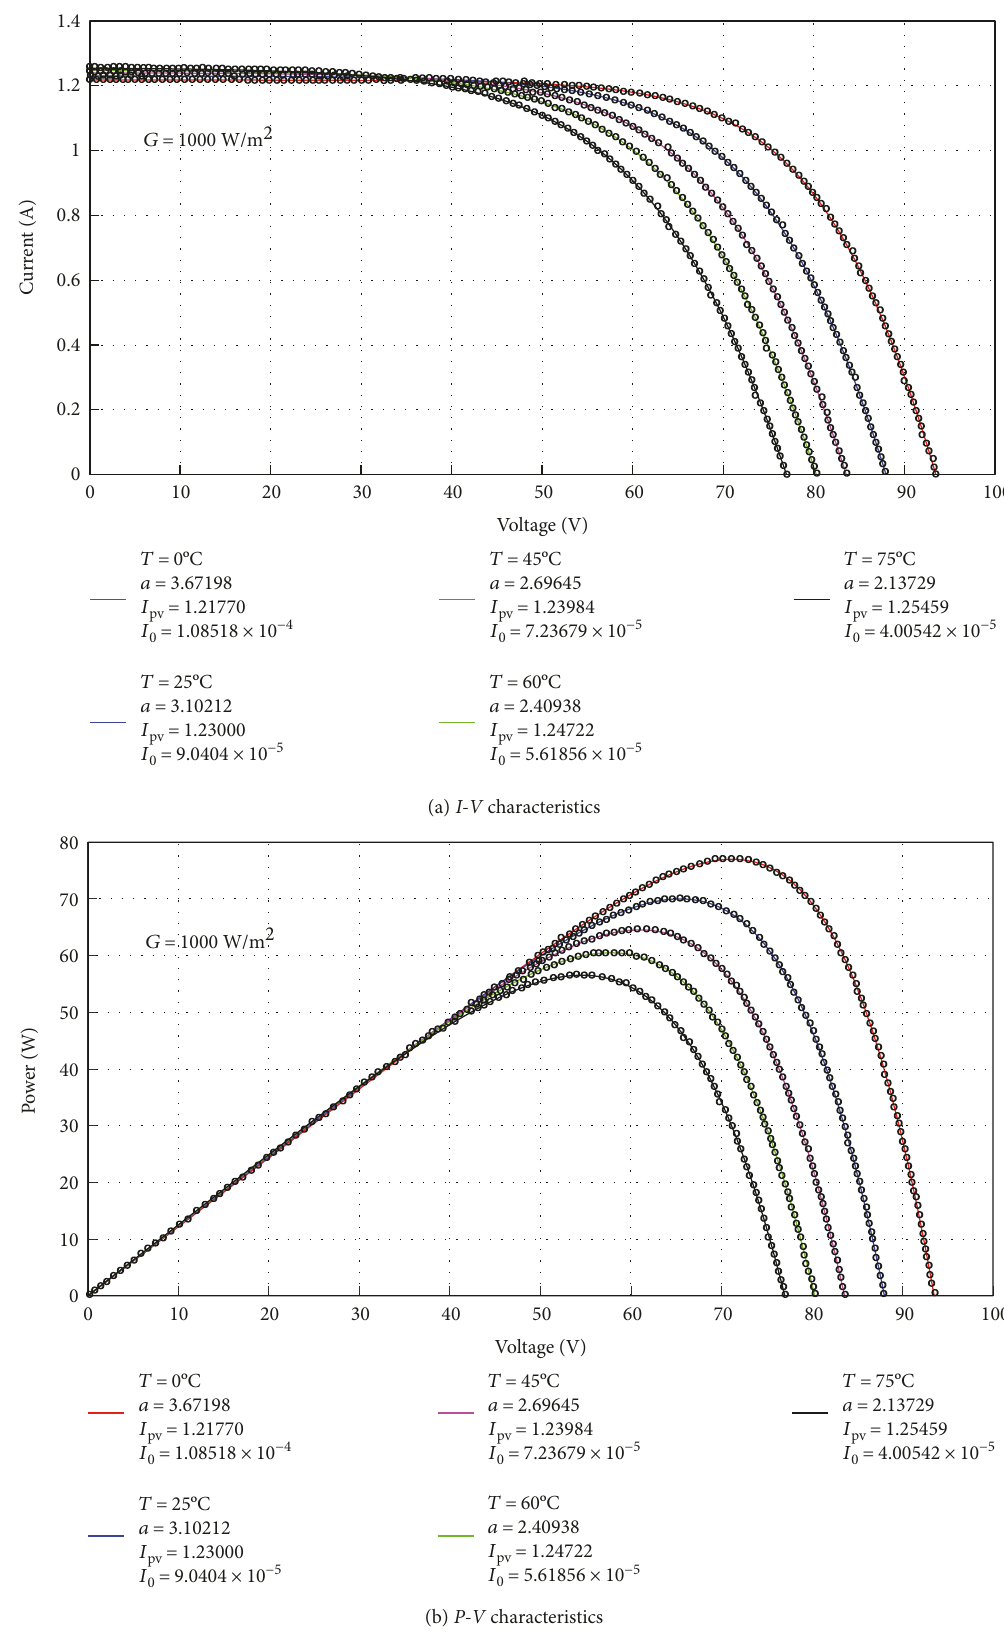
Figure 6: Characteristics and experimental data of the FS-270 PV module at di ff erent temperatures (irradiance constant =1000W/m 2